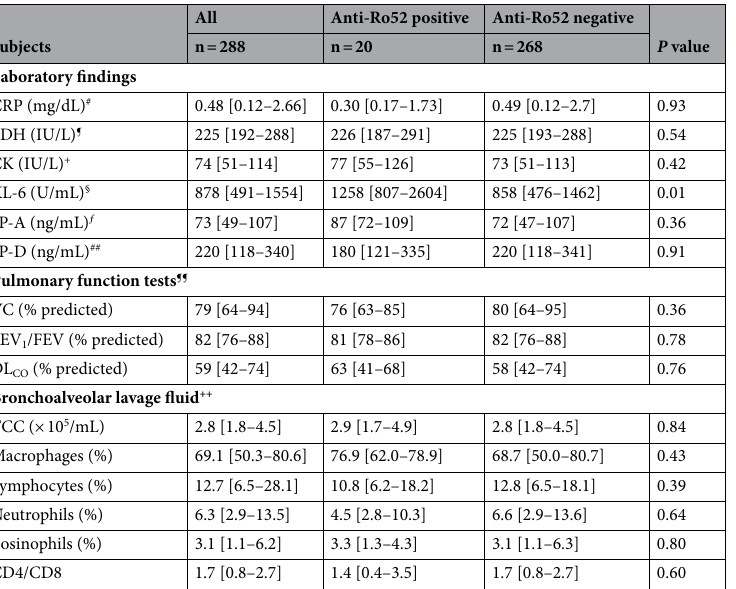
Table 4. Tests and findings of patients with/without anti-Ro52/tripartite motif-containing 21 antibodies (anti-Ro52). Data presented as median [interquartile range] or frequencies (%). n = 288, unless otherwise stated; # n = 279; ¶ n = 278; + n = 229; § n = 260; ƒ n = 137; ## n = 210; ¶¶ n = 209; ++ n = 218. Ro52: Ro52/tripartite motif- containing 21; CRP: C-reactive protein; LDH: lactate dehydrogenase; CK: creatine kinase; KL-6: Krebs von den Lungen-6; SP-A: surfactant protein-A; SP-D: surfactant protein-D; VC: vital capacity; FEV 1 : forced expiratory